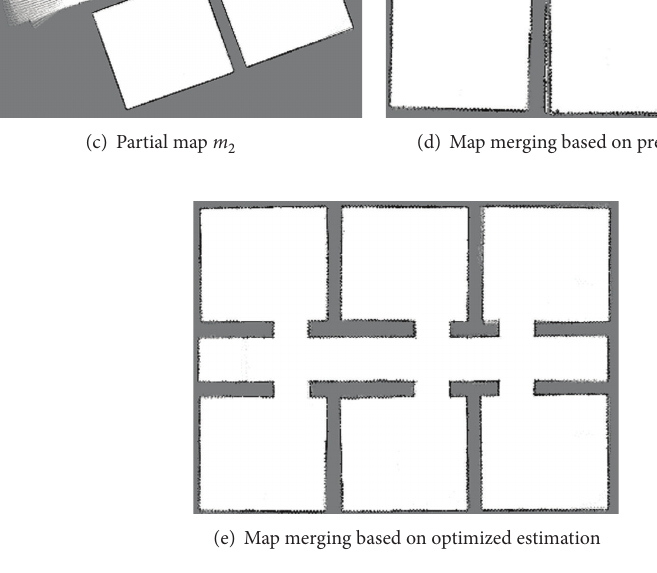
Figure 6: Experimental